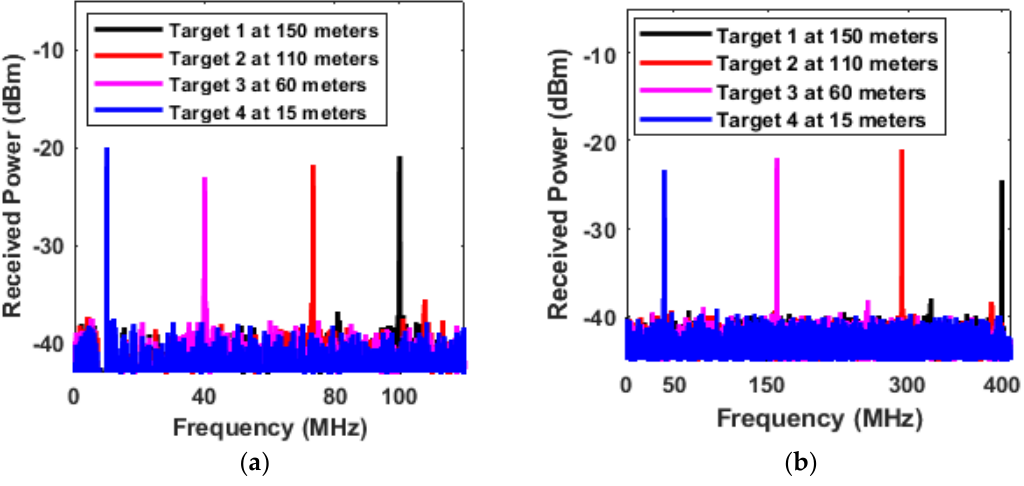
Figure 3. Power spectrum of de-chirped signal from multiple targets under clear atmospheric conditions ( a ) at 1 GHz and ( b ) at 4 GHz bandwidths.